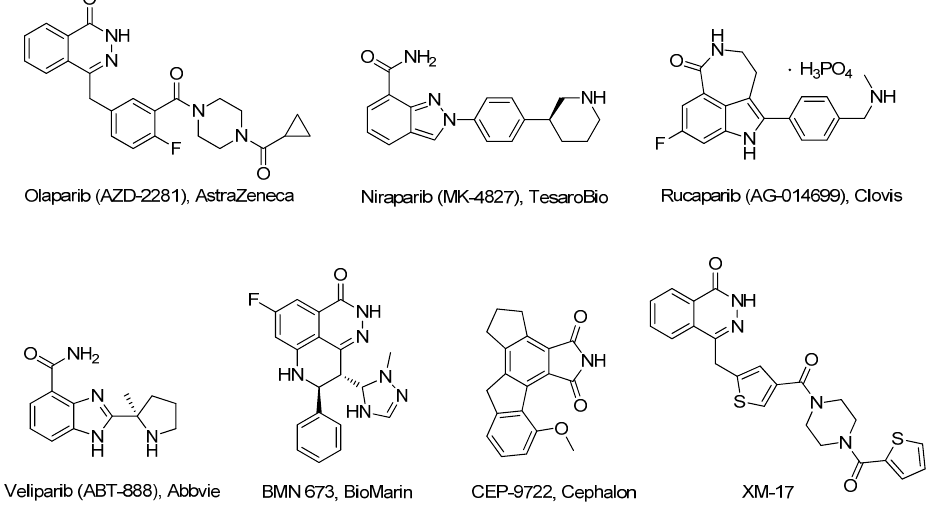
Figure 1. Structures of PARP-1 inhibitors.